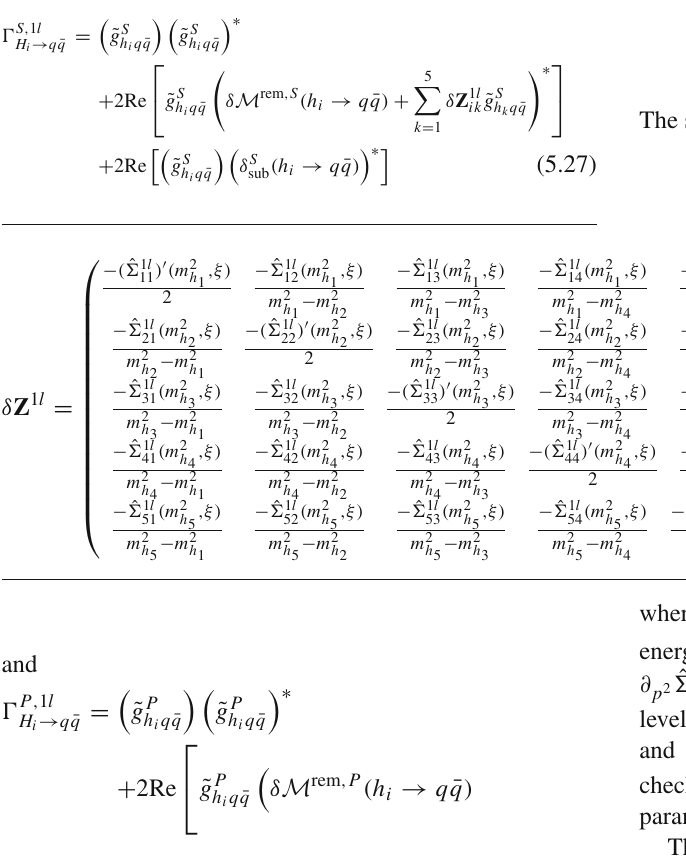
the pure one-loop terms, so that we define the pure one-loop / P correction to (cid:19) S H i → q ¯ q